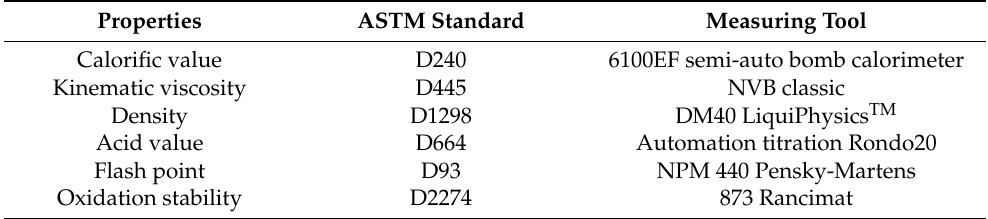
Table 1. Physicochemical properties, ASTM standards and measuring tools.